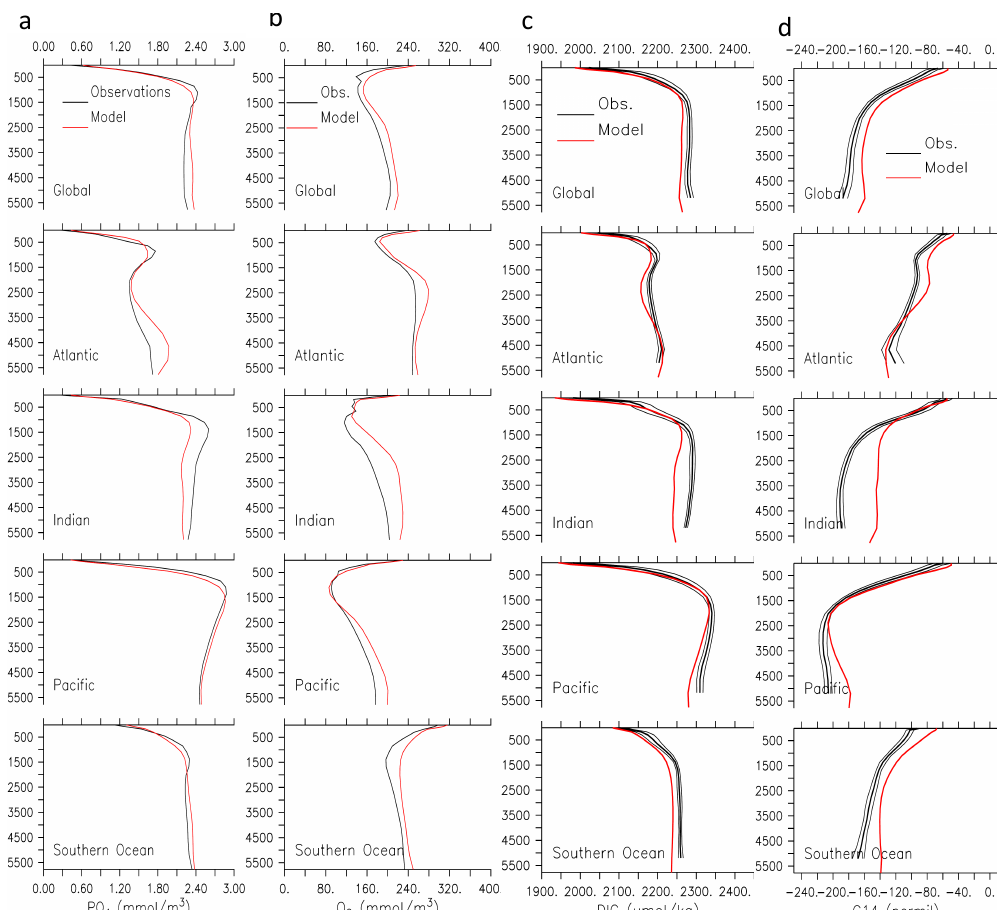
Fig. B2. Basin-scale model–data comparison of (a) PO − ε BD = 2, model experiment